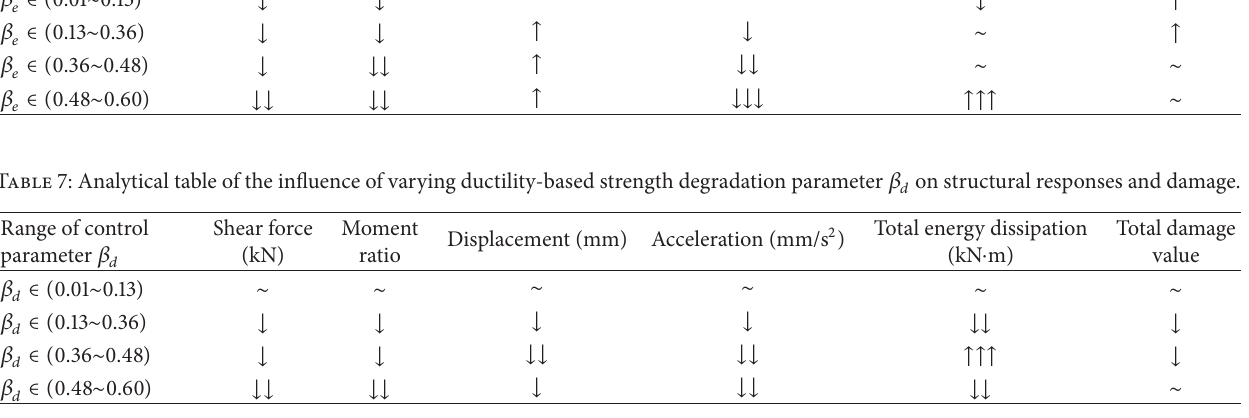
Table 6: Analytical table of the influence of varying energy-based strength degradation parameter 𝛽 𝑒 on structural responses and damage. Range of control parameter 𝛽 𝑒